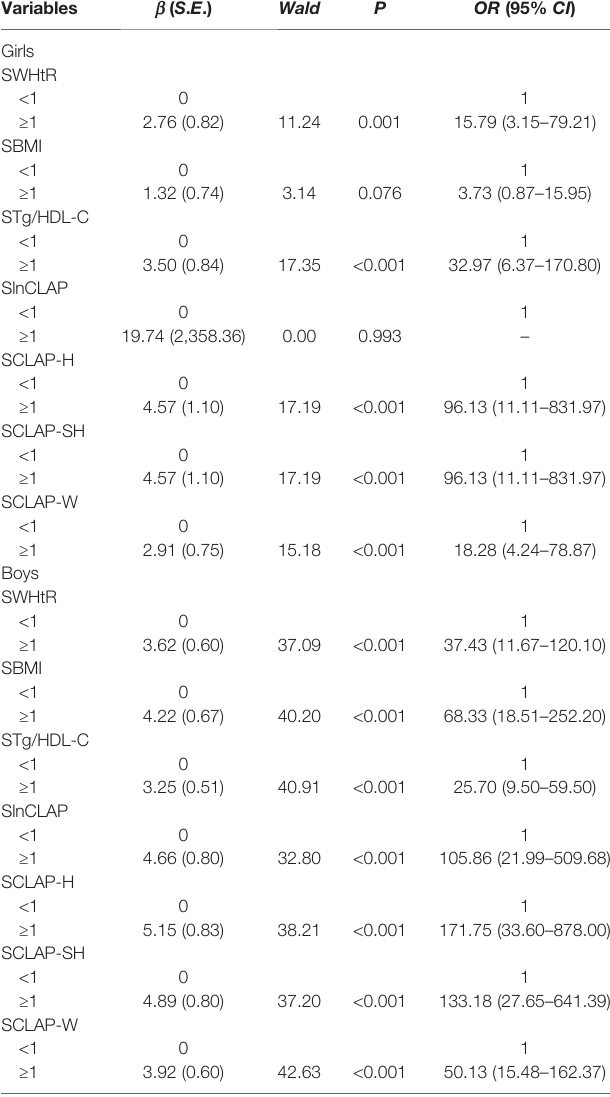
TABLE 4 | The areas under ROC curves of SBMI, SWHtR, SlnCLAP, SRCLAP- H, SRCLAP-SH, SRCLAP-W, STg/HDL-C, SlnCLAP combining SH, SlnCLAP combining SSH, SlnCLAP combining SW for predicting MS among